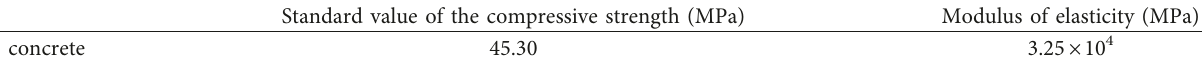
Table 3: Mechanical properties of the concrete.